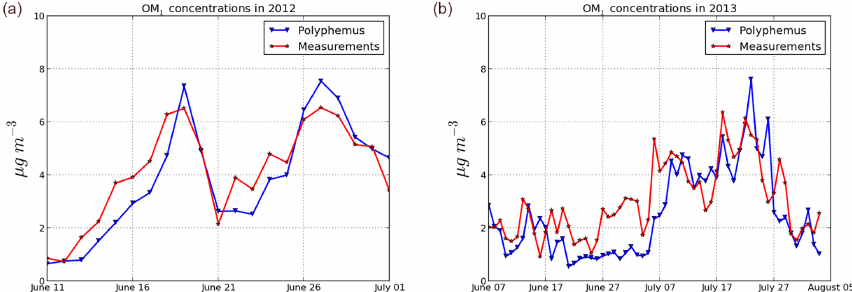
Figure 3. Comparison of measured and simulated daily OM 1 concentration at Ersa during the summer campaigns of 2012 (a) and 2013 (b) . Table 4. Statistics of model to measurements comparisons for hourly organic concentrations in particles of diameters lower than 1µm during the summer campaigns of 2012 and 2013. o and s are the observed and simulated means respectively. RMSE is the root mean square error, and MFB and MFE are the mean fractional bias and error respectively (see Appendix